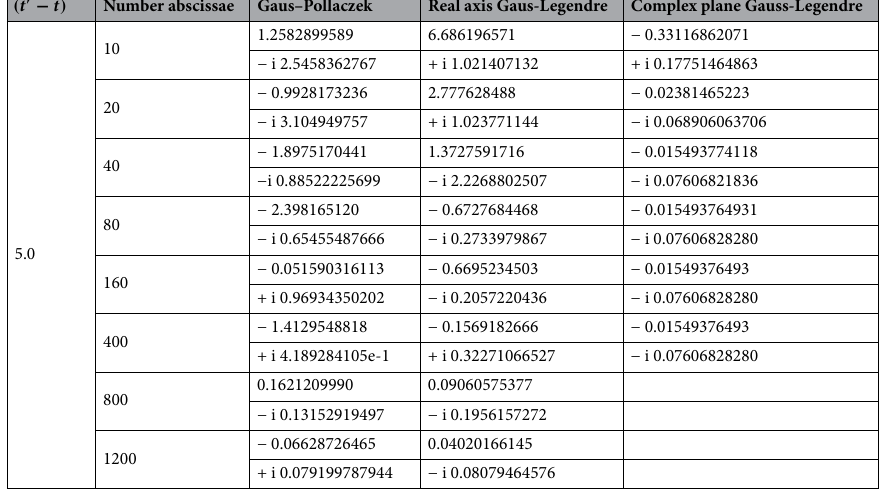
ρ l ( x ) dx (cid:31)(cid:30)